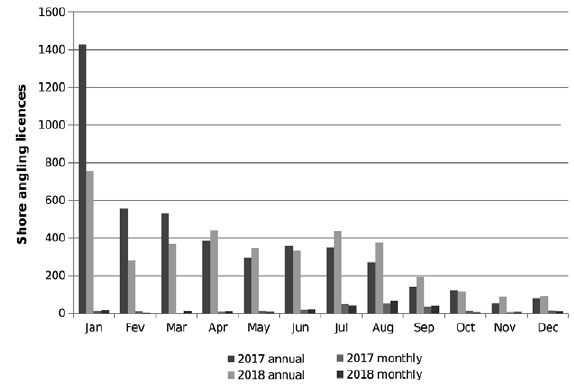
Fig. 2. – Evolution of the number of shore angling licences in 2017 and